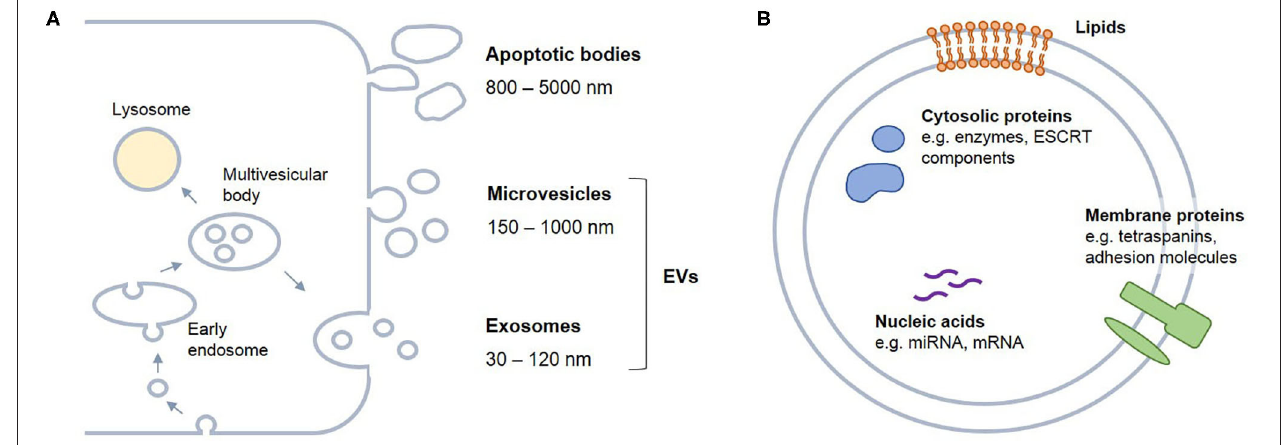
FIGURE 1 | Biogenesis and content of extracellular vesicles (EVs). EVs are secreted by any cell type. (A) Based on the biogenesis route, different kinds of vesicles can be distinguished. Apoptotic bodies arise from membrane blebbing of apoptotic cells. Microvesicles derive from outward budding of the plasma membrane, while exosomes originate from the endo-lysosomal compartment and are released from the cell after fusion of multivesicular bodies with the plasma membrane. (B) EVs are enclosed by a lipid bilayer and carry membrane lipids and proteins, cytosolic proteins as well as nucleic acids, such as miRNAs and mRNAs. It is widely assumed that EV cargo mirrors the characteristics of the parent cell. ESCRT, endosomal sorting complexes required for